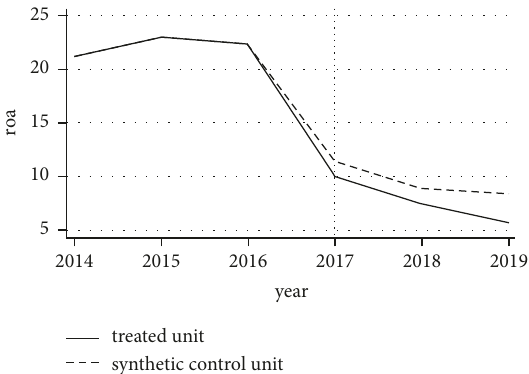
Figure 3: ROA figure of Xinjiang torch. Note: Xinjiang torch was listed through the IPO green channel in 2017. And before its being listed, the treatment group and control group fold share the same trend. After 2017, both experienced a decline, but the decline in the treatment group was more severe, which indicates that Xinjiang Torch has experienced a change in performance after being listed through this policy (the figure is directly exported by Stata software).